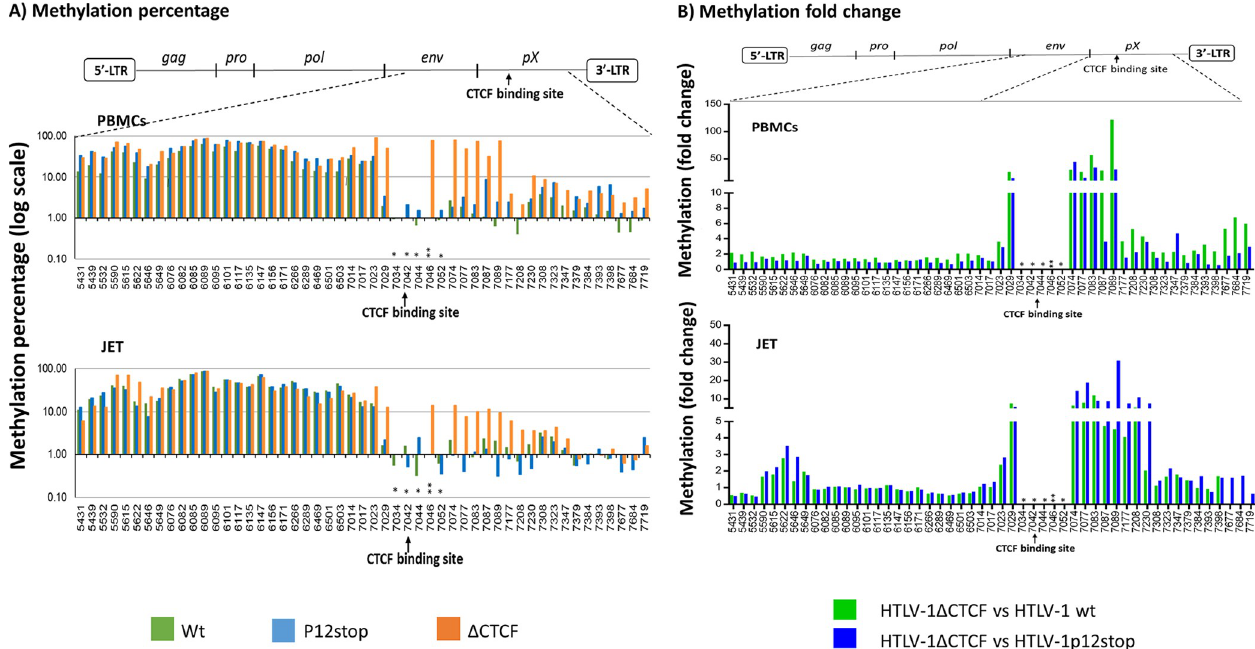
Fig 2. Deletion of the CTCF binding site of HTLV-1 (vCTCF-BS) results in expansion of DNA methylation in the pX region of the provirus. DNA methylation of the HTLV-1 provirus is presented as the percentage of methylated CpG (A) or fold change (B) (Y-axis) at the indicated locations of the viral DNA (X-axis). The schematic diagram of HTLV-1 provirus indicates the regions examined by bisulfite treatment and DNA sequencing as described in the Materials and Methods. Upper panel: HTLV-1 immortalized bulk population of PBMCs; lower panel: HTLV-1 infected bulk population of JET cells. CTCF binding site: 7041-7052 as indicated by an arrow. � Lost CpG sites, �� New CpG site due to the introduced mutations in vCTCF-BS. Nine CpG sites (5649- 6076), 19 CpG sites (6503-7014), 8 CpG sites (7398-7615) are not shown because of unsuccessful PCR amplification in these regions after bisulfite treatment.